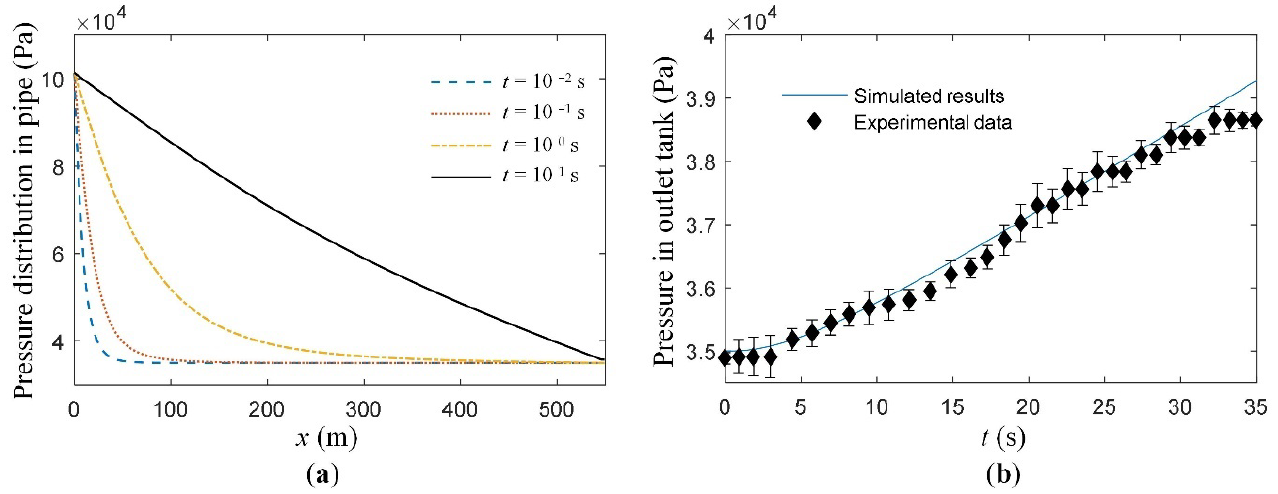
Figure 8. Dynamic of pressure in the pipeline ( a ) and in outlet tank ( b ).